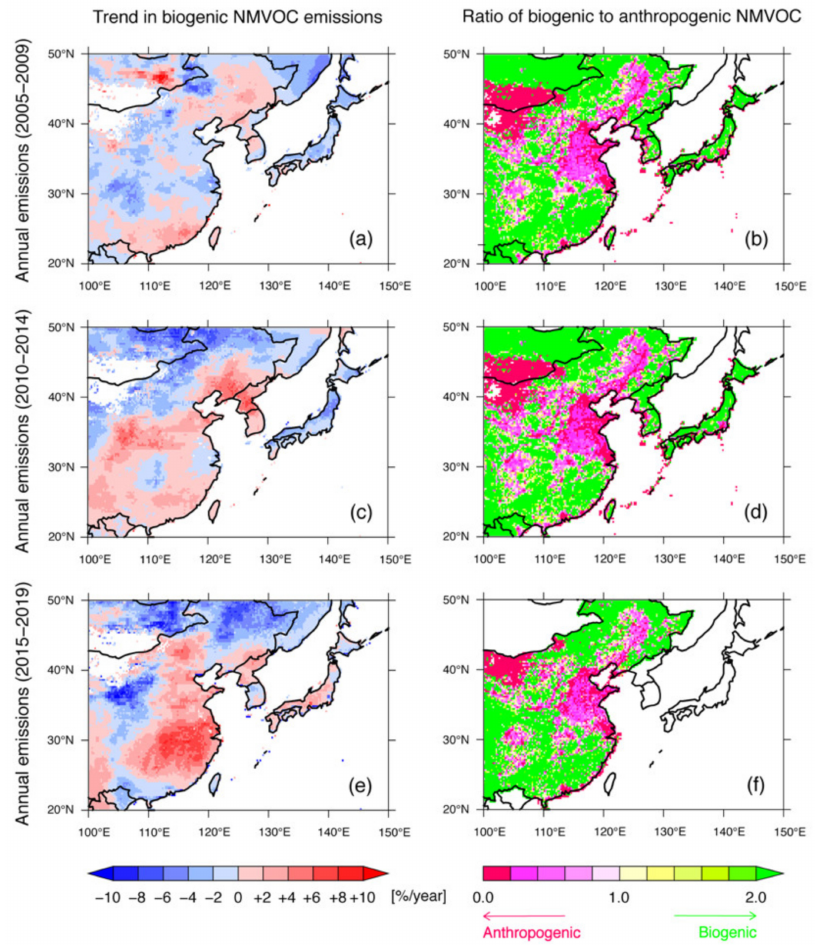
Figure 9. ( a , c , e ) Linear regression analyses for the annual amount of biogenic NMVOC emissions and ( b , d , f ) the ratio of biogenic to anthropogenic NMVOC emissions over East Asia during the 5-year periods of ( a , b ) 2005–2009, ( c , d ) 2010–2014, and ( e , f ) 2015–2019. White areas indicate no available